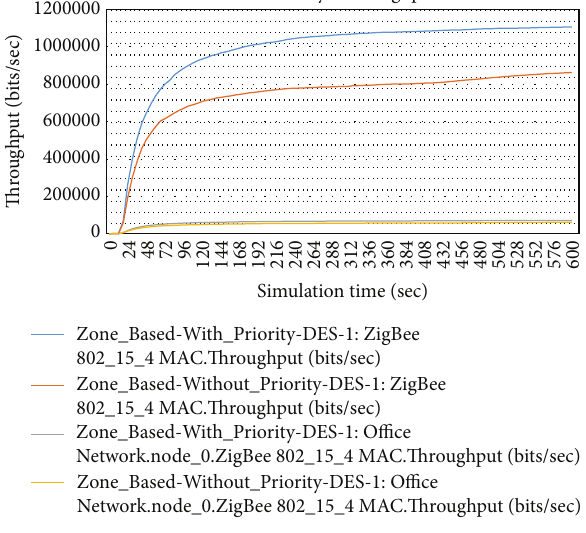
Figure 5: MAC throughput (bits/sec) for global model and Coordi- nator (node